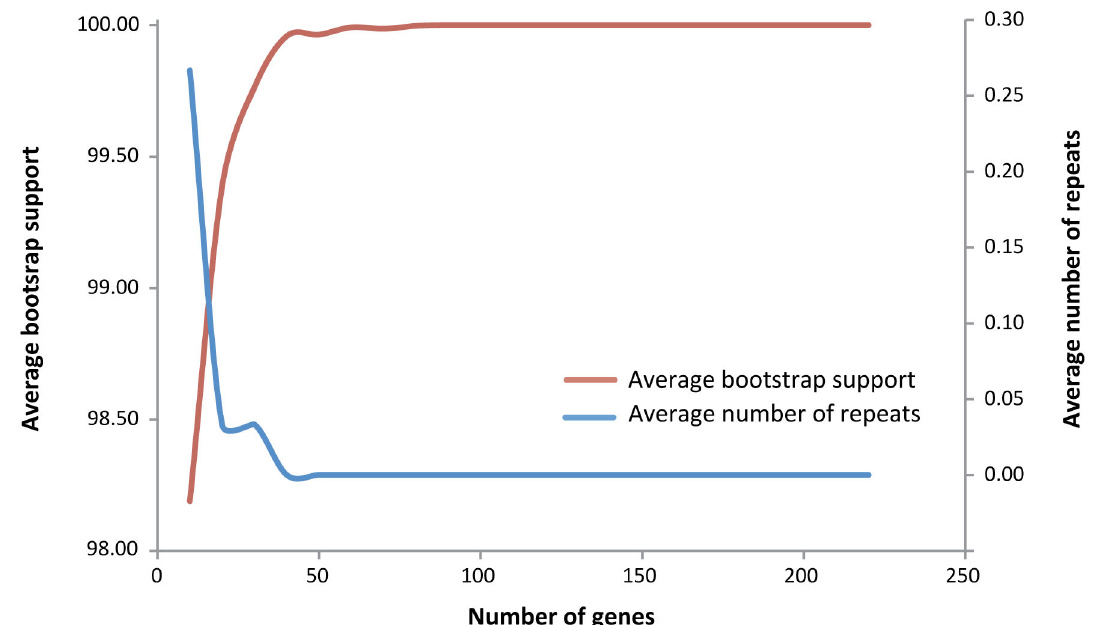
Figure 3. Average bootstrap support and the gene number in the phylogenetic analyses based on data from Table S4.